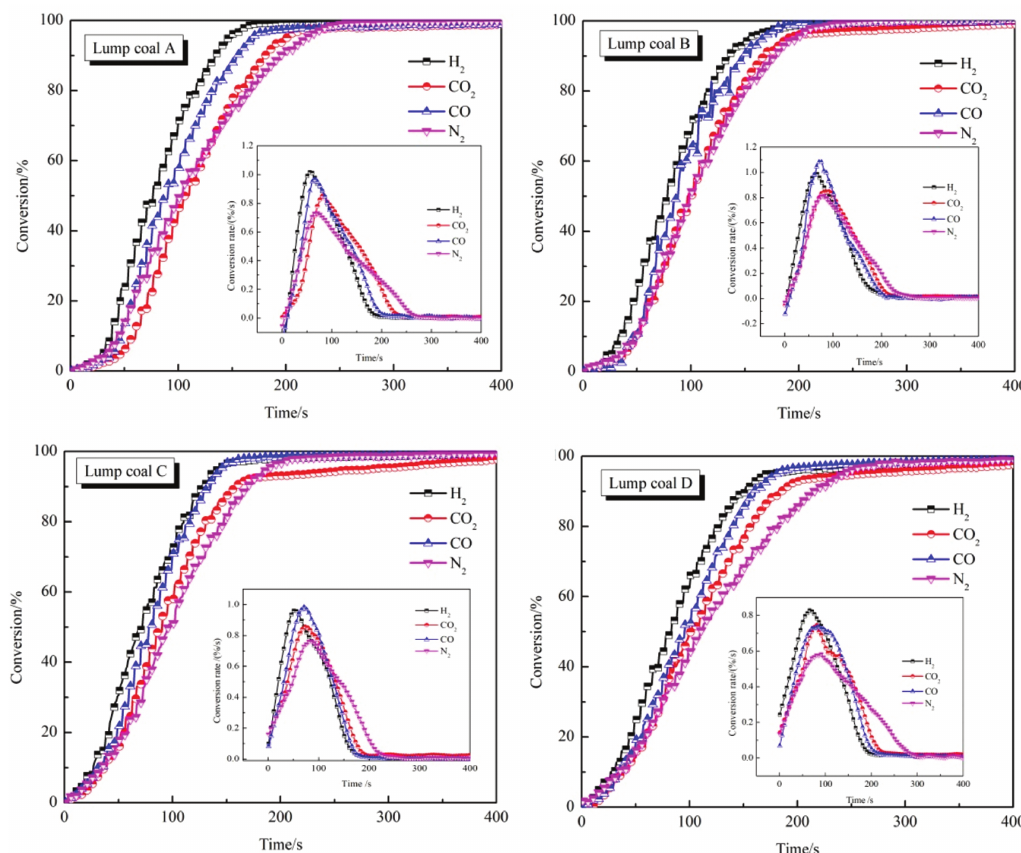
Figure 9: Pyrolysis conversion and conversion rate curve of lump coal under different atmospheres.